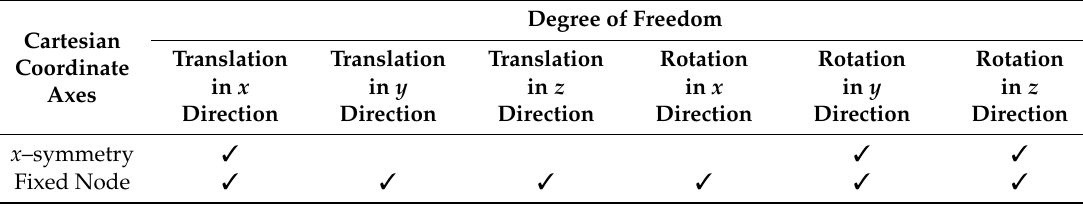
Figure 6. Schematic representation of: ( a ) loading direction and surface; ( b ) boundary conditions of the symmetrical model in finite element modeling. Table 3. Degrees of freedom for modeling of closed-cell Aluhab foam.